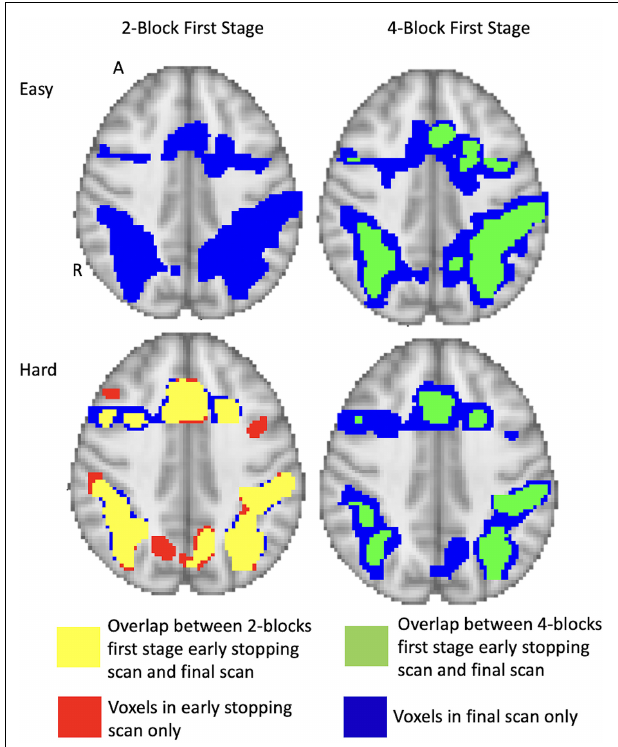
FIGURE 7 | Full brain activation maps showing the overlapping voxels between the different stopping points (using 2-blocks first stage, 4-blocks first stage and final scan). Top row shows the easy level and bottom row shows the hard level for 1 subject (number 9). The voxels that are active only at full duration are shown in blue. Those only active after 2-blocks or 4-blocks of stimulus administration are in red. Yellow shows the overlap between full duration and 2-block first stage early stopping scans. Green shows the overlap between full duration and 4-block first stage stopping scans. Thresholded at z = 3.10 at first scan after the first stage. Results overlaid on MNI template, slice z = 56 shown. R = right, A =